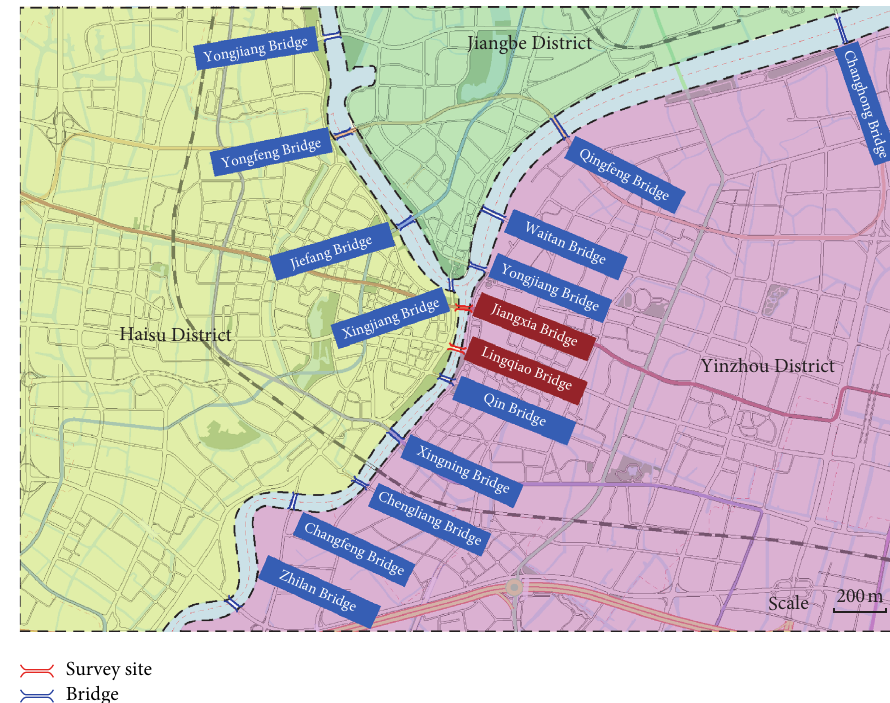
Figure 2: Overview of the research